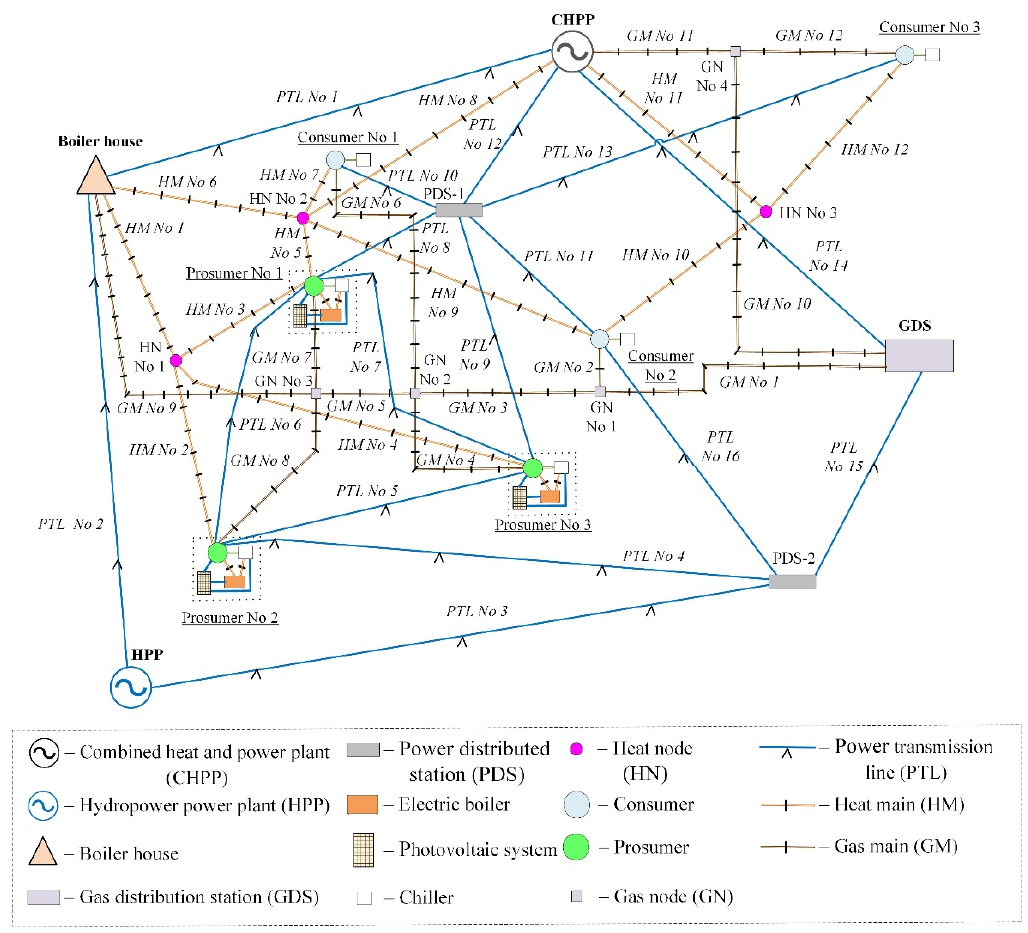
Figure 5. The scheme of the modelled integrated energy system.